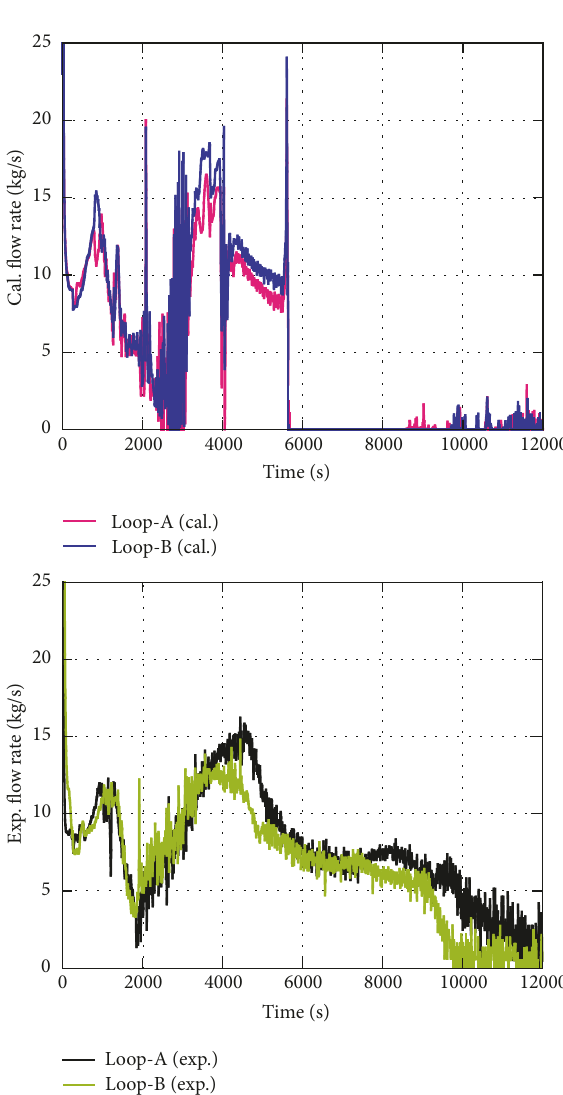
Figure 20: TR-LF-17test and RELAP5 results for primary mass flow rate in each